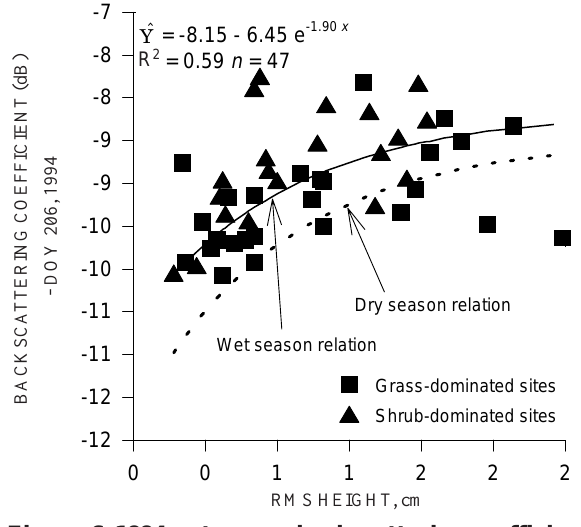
Figure 6. 1994 wet season backscattering coefficient dependence on soil roughness of the Walnut Gulch Experimental